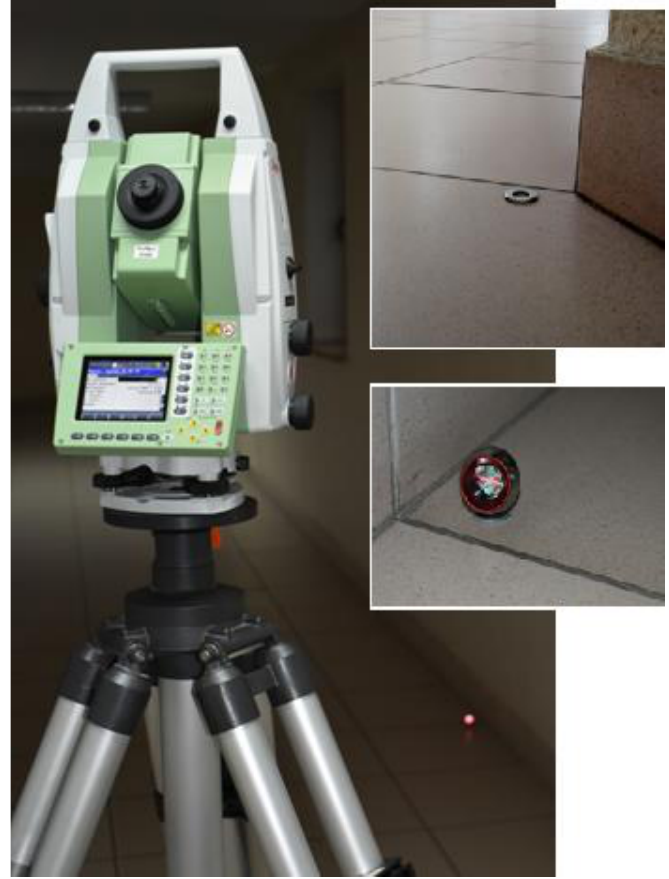
Figure 2. Leica TDRA6000 measuring device and method of stabilizing network points [own analysis].